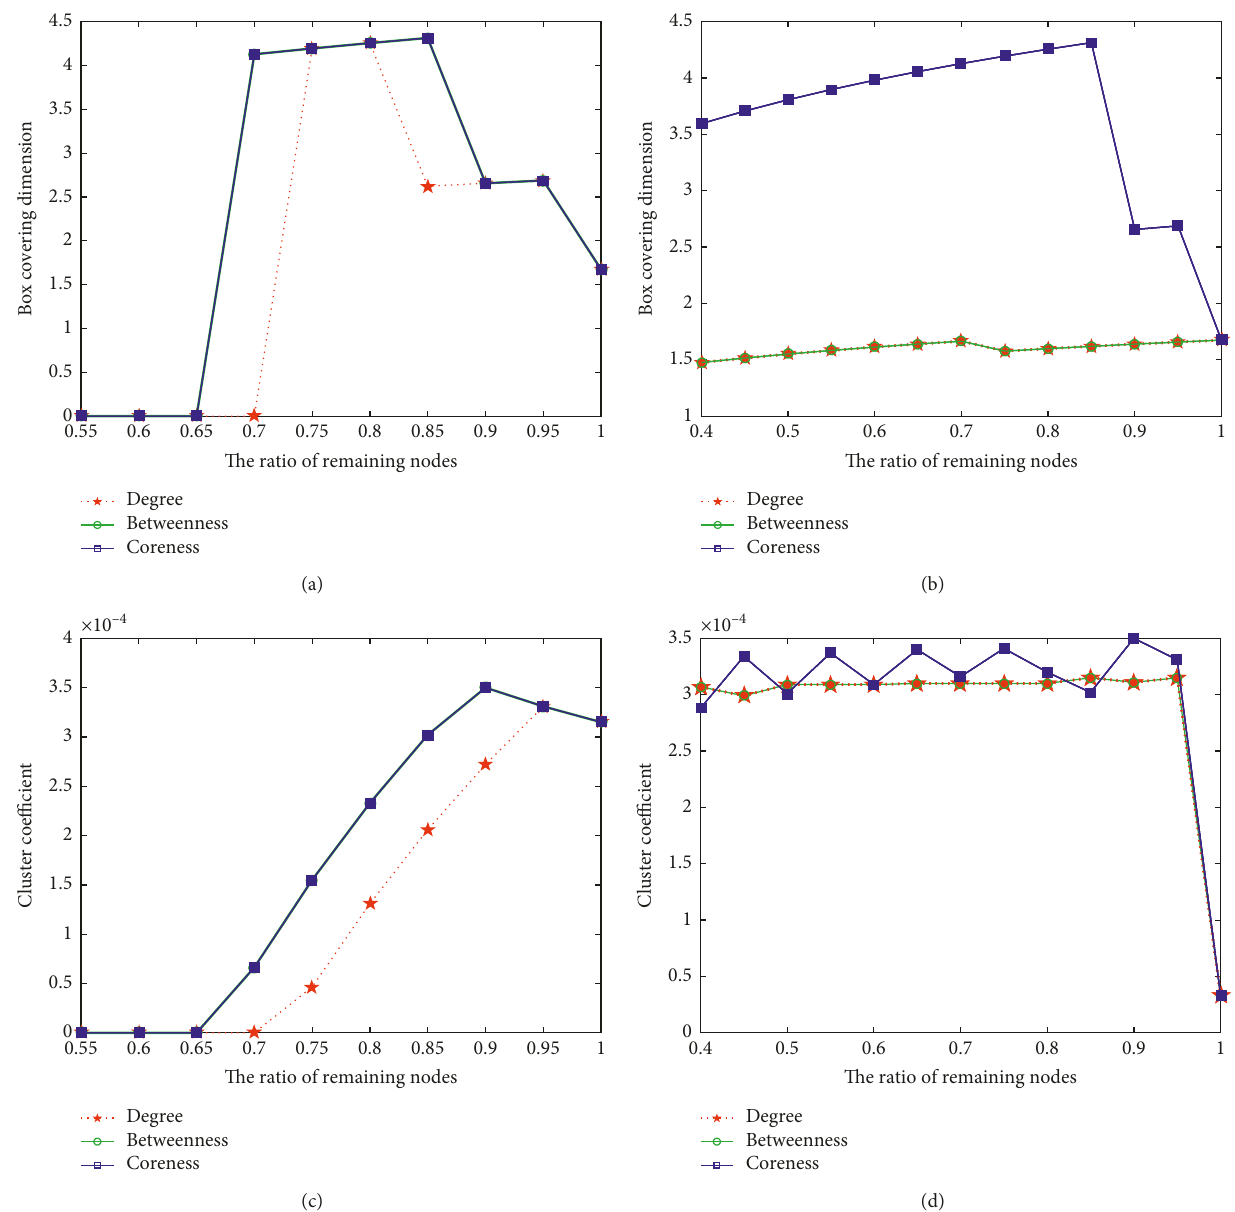
Figure 3: Changes of box dimension and cluster coefficient after nodes are removed in the ascending and descending order. The X -axis represents the number of nodes remaining in the network. (a) The changes of box dimension after nodes removal in the descending order of SFnet. (b) The changes of box dimension after nodes removal in the ascending order of SFnet. (c) Cluster coefficient changes with nodes removal in the descending order of SFnet. (d) Cluster coefficient changes with nodes removal in the ascending order of